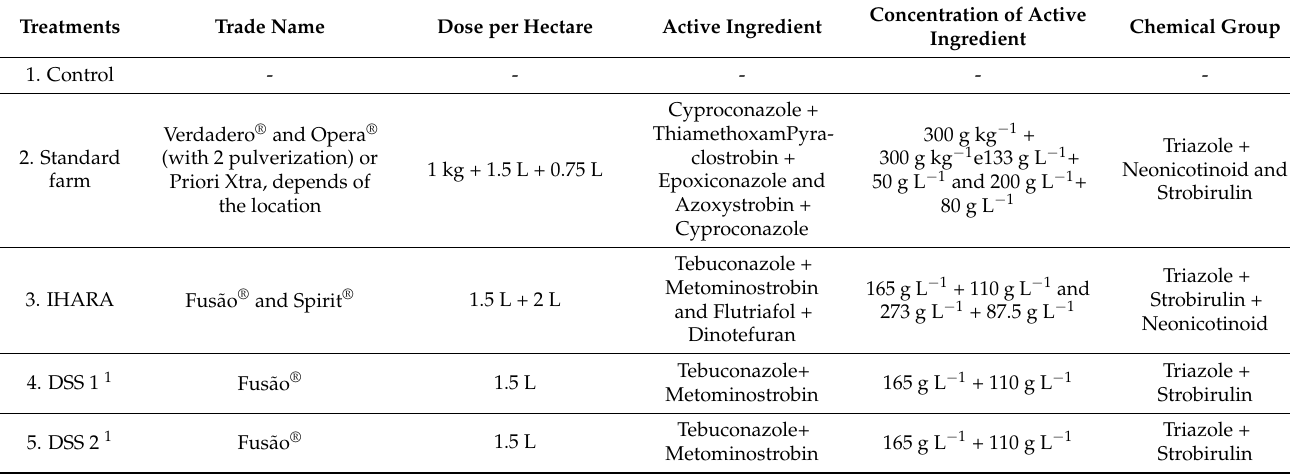
Table 2. Treatments, trade name, dose per hectare, active ingredient and their concentration and chemical group, used in the areas for validation of the warning systems in the 2018/2019 and 2019/2020 harvests.